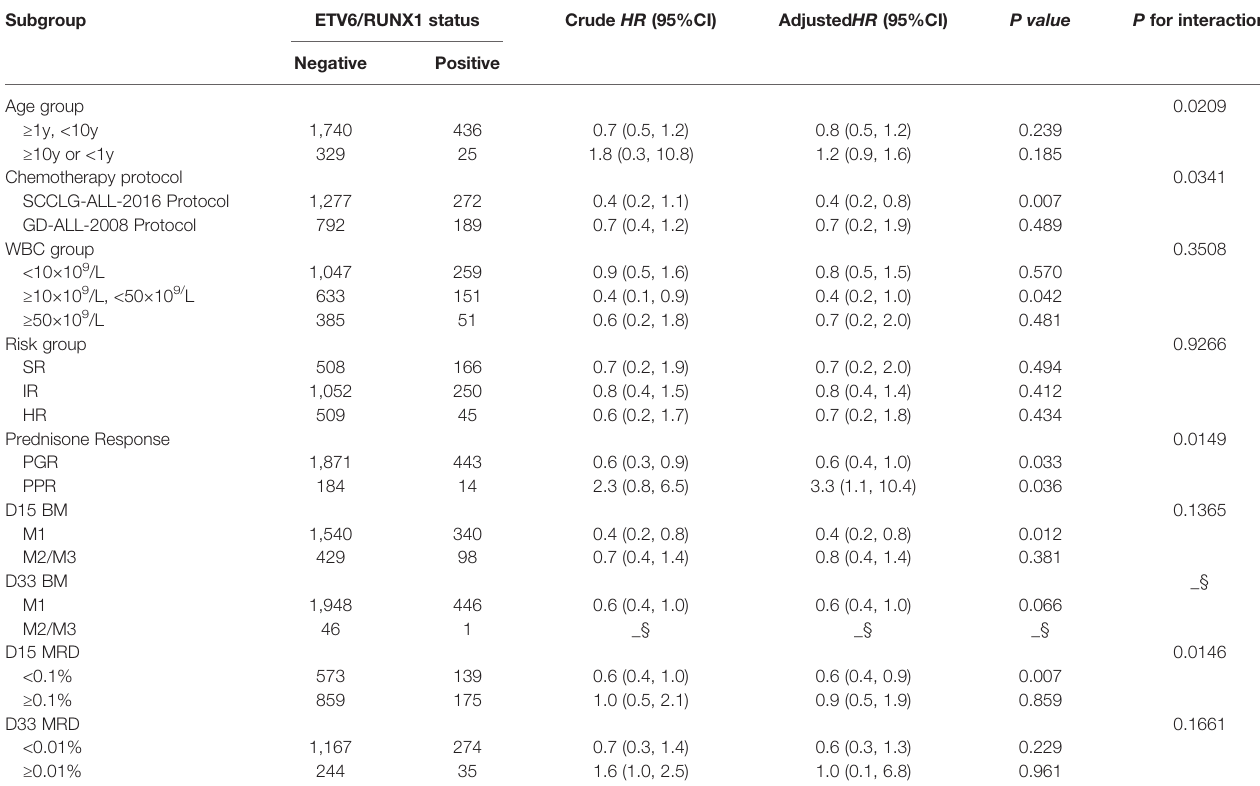
TABLE 5 | Subgroup analysis of the associations between ETV6/RUNX1 status and OS.